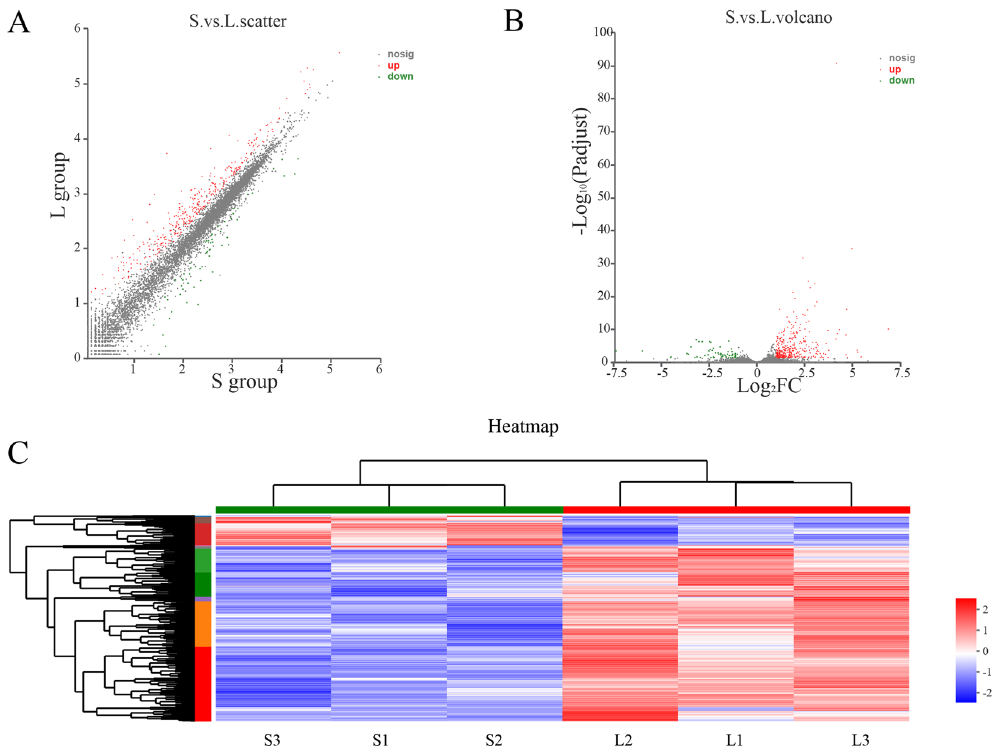
Figure 5. Scatter plot, volcano plot, and heat-map of differentially expressed genes (DEGs). ( A ) The scatter plot was used to assess variations in gene-expression levels between small and large knobs in geese. ( B ) Volcano plot showing DEGs. The X-axis, log 2 FC represents the logarithm of the expression ratio (fold change), and the Y-axis represents adjusted P (P adjust) value. Each dot represents a specific gene. Red dots represent genes expressed at significantly higher levels in geese with large knobs, and green dots represent genes with significantly lower relative expression. Genes showing no significant differences in expression levels are represented with gray dots. ( C ) Hierarchical-clustering analysis for the transcriptome profiles of knobs in the S versus L groups. The heat- map presents the mean relative abundances of genes with a color scale. FC